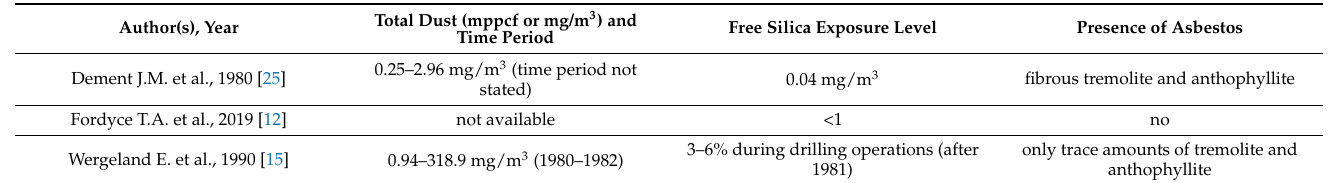
Figure 1. Flowchart of the study selection for the meta-analysis based on the inclusion and exclusion criteria. Table 1. Cohort exposure levels to total dust, silica,